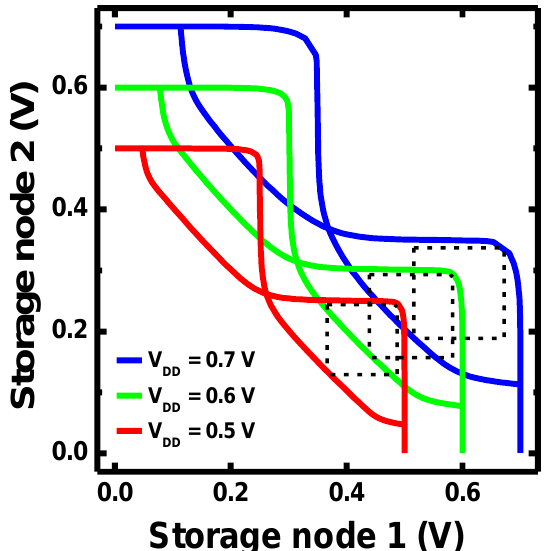
Figure 11. The butterfly curves of the 6T-SRAM cell, which was constructed with two designed N1 CFET inverters and two NMOS access transistors. The SNM of ~120 mV as V DD down to 0.5 V is obtained.